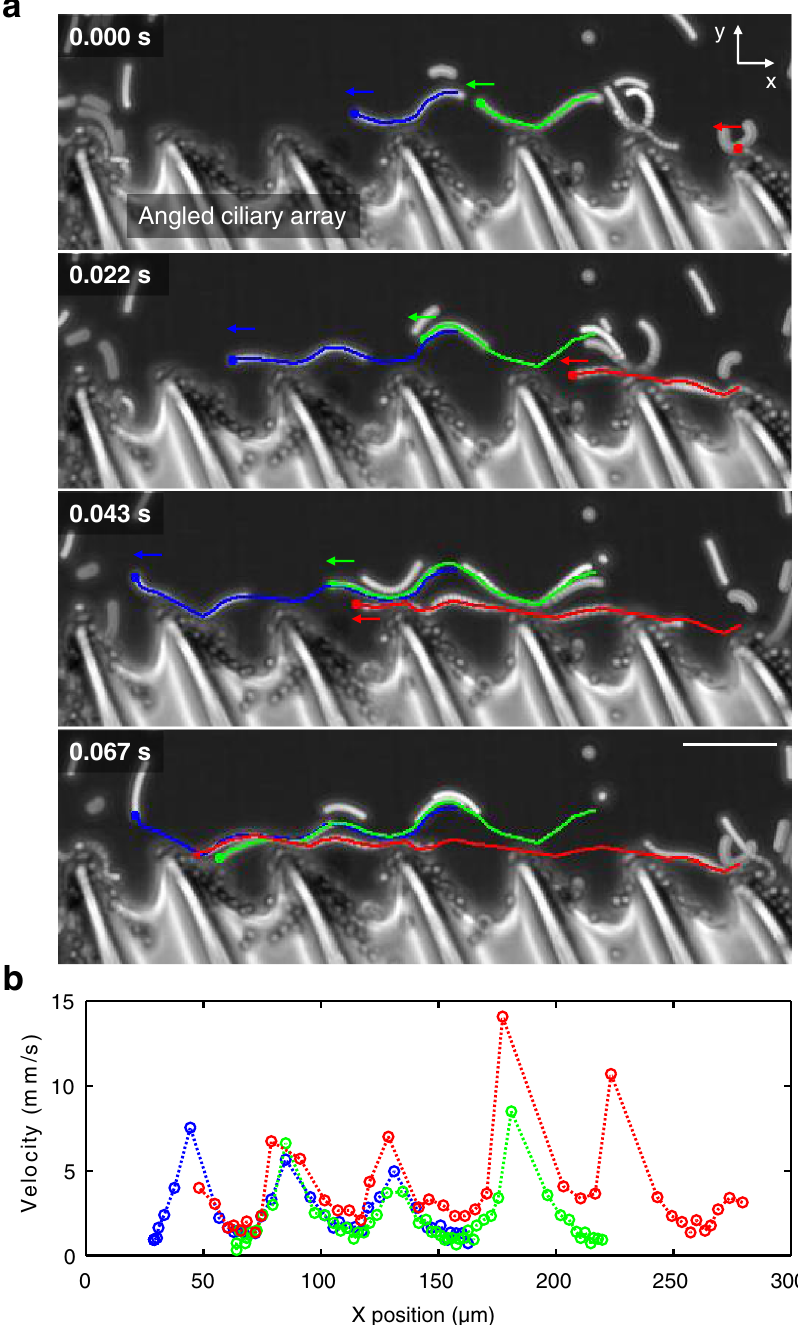
Fig. 2 Tangential fl ow along angled ciliary array when exposed to ultrasound. a Image sequences (at t = 0.000 – 0.067 s) demonstrate ~6 μ m tracer particles, indicated by red, green, and blue lines, traveling along one cilium tip to the next from right-to-left in the direction the tips are angled at excitation frequency and amplitude of 33.7 kHz and 5 V PP , respectively (see also Supplementary Movie 2). Due to residual non-polymerized and sticky polymer material on the surface of individual cilia and in between located web-like structures, tracers adhere to the structure ’ s surface. b Velocity analysis of the tracers (Source Data 1 and Supplementary Software 1), along the horizontal axis of the image sequences in a , revealed a cyclic acceleration/deceleration pattern. Particles reached maximum speeds when they approached a ciliary tip, followed by a deceleration phase. Scale bar, 50 μ low-velocity tracers having passed the last cilium (Supplementary Fig. 3a, the fl ow fi eld for a − ciliary band is analogous to a fl uid sink Fig. 5 and Supplementary Movie 3). Similarly, fl uid fl ow along the and produces an inward fl ow at the center (see also Supplementary left half produces a counter-clockwise (CCW) vortex. Thus, an Movie 4). In a control experiment, when a straight ciliary array was analogous fl uidic source is formed due to the build-up of the two exposed to an acoustic fi eld, we observed no signi fi cant particle counter-rotating vortices, producing an outward fl ow at the center transport or fl uid fl ow from one cilium to another (Supplementary of the + ciliary band, as shown in Fig. 3a. Figure 3b likewise Fig. 6 and Supplementary Movie 5). Instead, the tracer particles illustrates the liquid fl ow fi eld near a − ciliary band. In contrast to were trapped in small vortices around each cilia tip. Therefore, an